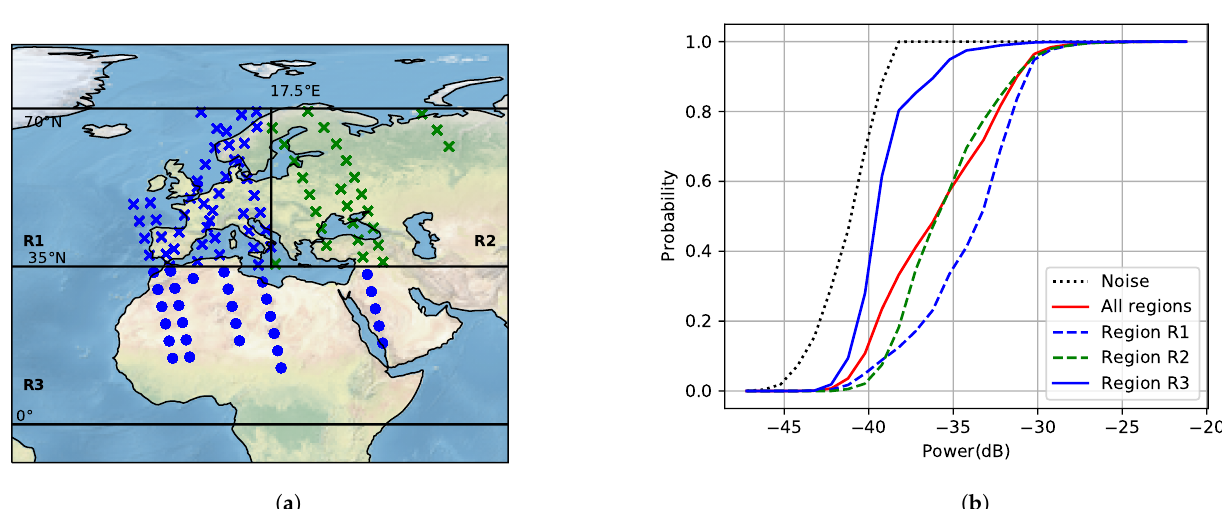
Figure 9. Power distribution over Europe, northern Africa, and the Middle East. ( a ) Measurement locations over several orbits. The northern regions cover 35 ◦ of longitude and latitude; and the southern region, 70 ◦ of longitude and 35 ◦ of latitude. ( b ) Empirical Cumulative Density Function (ECDF) of received power over the three regions and all frequency bins within the 3 dB bandwidth, including the noise floor measurements (black dotted line). The blue continuous line is linked to the blue circles in the map and dashed lines to crosses. Red line is the ECDF of all the points in the map. Figure 10 shows the results of the same procedure applied to the measurements carried out over America, redefining the areas of interest. The coastal regions ( R 4, R 6 and R 7) cover 40 ◦ of longitude, while the middle region ( R 5) covers 30 ◦ . The latitude limits are 0 ◦ , 35 ◦ , and 70 ◦ , as shown in the map. The interference levels are lower than in Figure 9b. The regions that are more affected by the interference are R 4 and R 6. Around